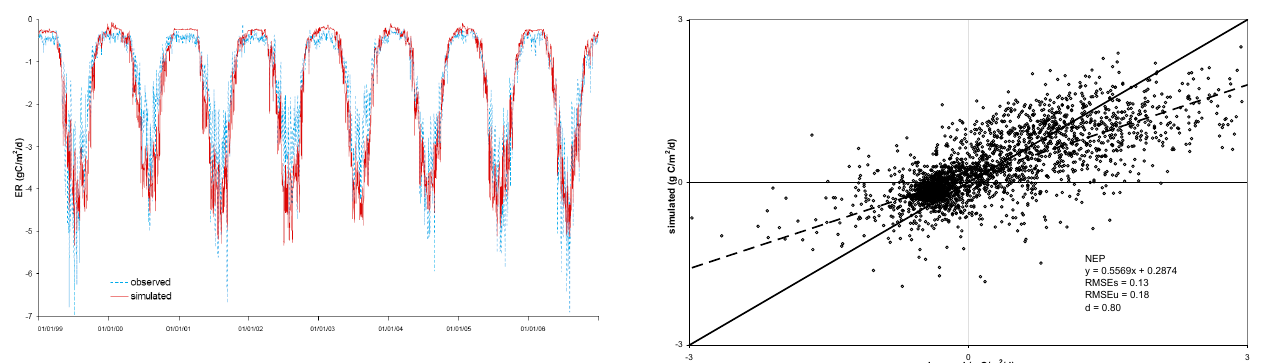
Fig. 3. The time series of hourly measured (blue dashed line) and simulated (red solid line) ER for 1999–2006.